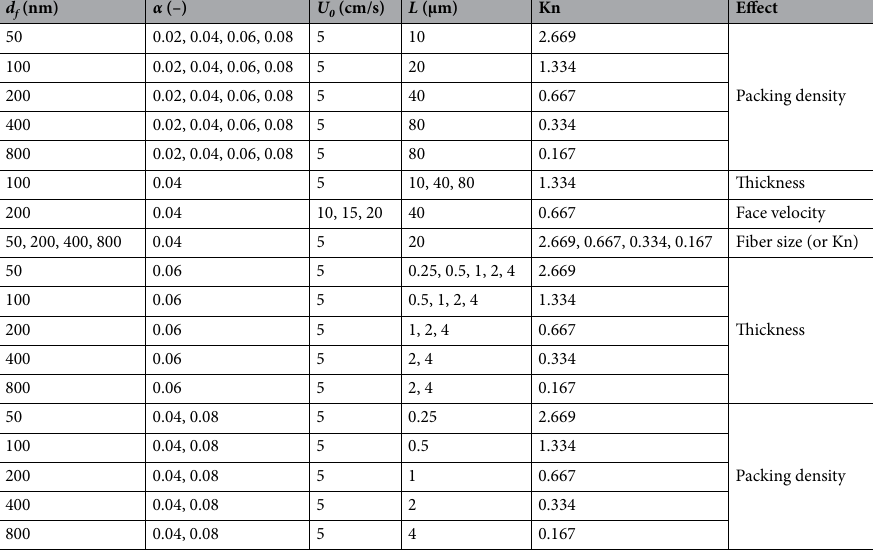
Table 1. Filtration parameters of 56 cases for the numerical study on nanofiber